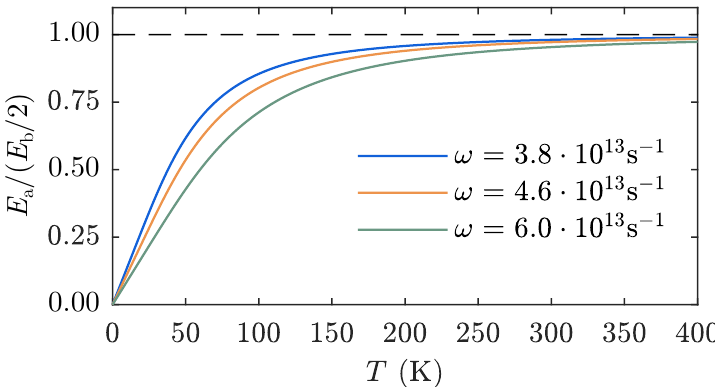
Figure 3. Normalized small-polaron hopping activation energy E a over E b /2 as a function of temperature. Note the different slopes and absolute values at different phonon frequencies, ω , when lowering the